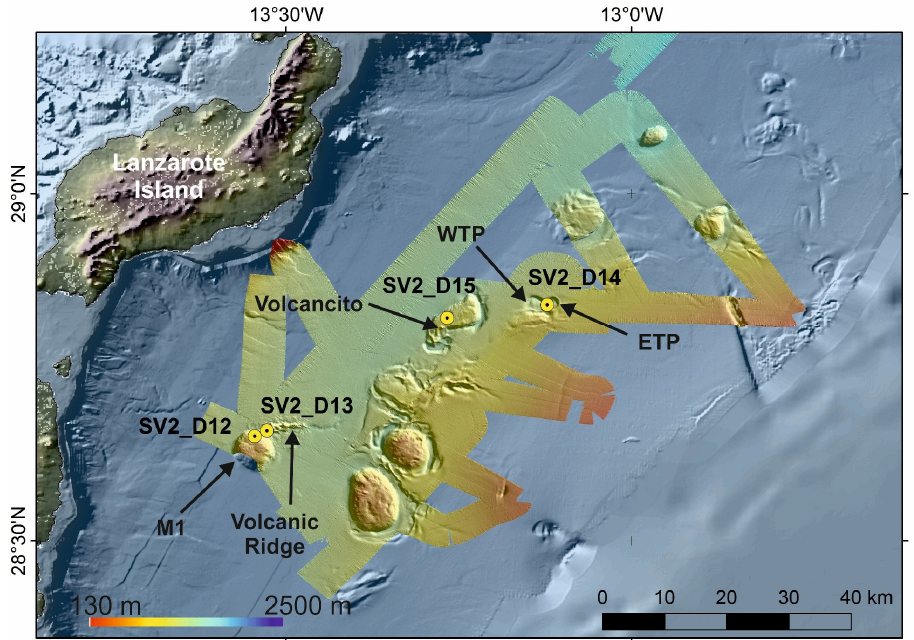
Figure 7. Bathymetric map obtained along the SUBVENT-2 expedition on board RV Sarmiento de Gamboa . The main characteristics of the seafloor such as sub-circular domes, volcanic ridges, marginal channels and circular to elongated depressions are highlighted. Locations of dives (from SV2_D12 to SV2_D15) are also shown as circles. M1: Dome; WTP: Western Twin Pool; ETP: Eastern Twin Pool.